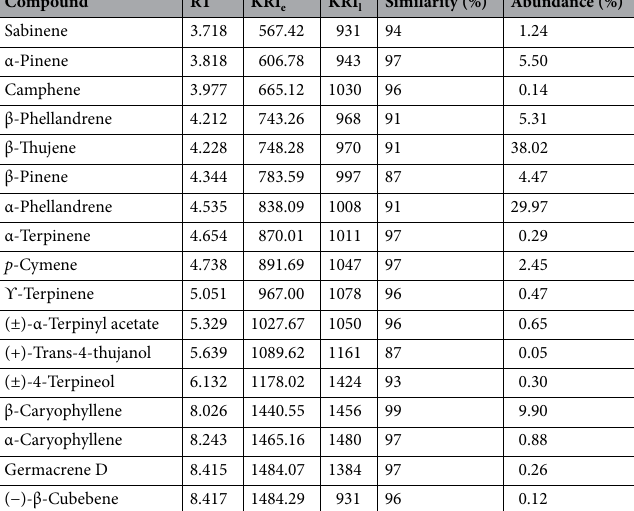
Table 1. Compounds present in the essential oil of Bursera morelensis identified by gas chromatography- mass spectrometry. RT retention time, KRIe Kovats Retention Index estimated (column